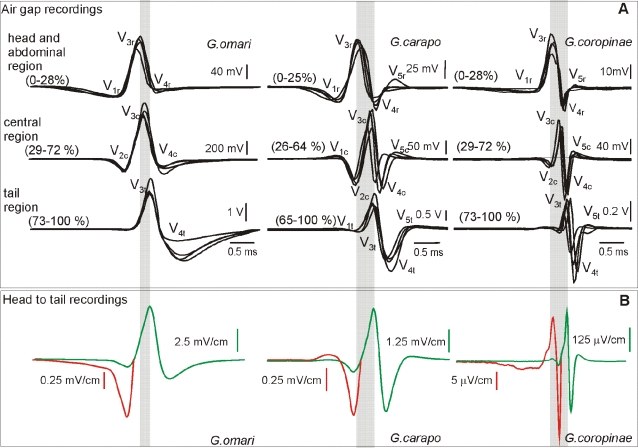
Electromotive force pattern of the three species.A) The air gap technique shows regional variations in the electric organ discharge electromotive force pattern. Note the presence of a smooth negative component and the advance of the main positive peak in the rostral regions of all fishes (marked by the widths of the gray bands), and the differences in the total duration of the electric organ discharges. B) A head to tail recording of the field between two electrodes separated 40 cm is shown below the air gap recordings (gray traces) to show the correspondence between the different deflections. Insets in red show a magnified version of the same waveforms for better showing the small early components. Note that different components of opposite polarity generated at different regions may overlap in time. For the sake of generality we name these components with a numeral sub index indicating the temporal order and a literal sub index indicating the spatial origin (r for rostral, c for central, and t for tail).